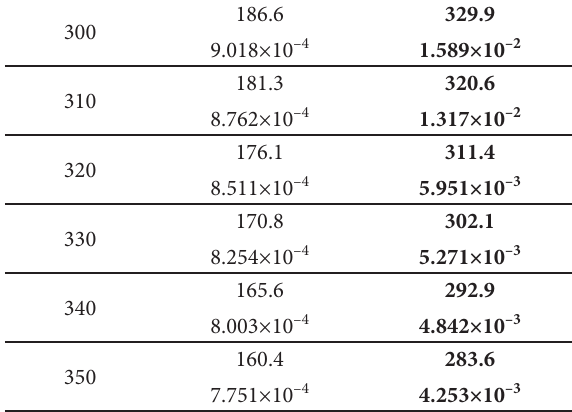
Table 1. Strains and stresses (MPa) in the body of the automatic coupler Transition between the T, kN head and the body (2)